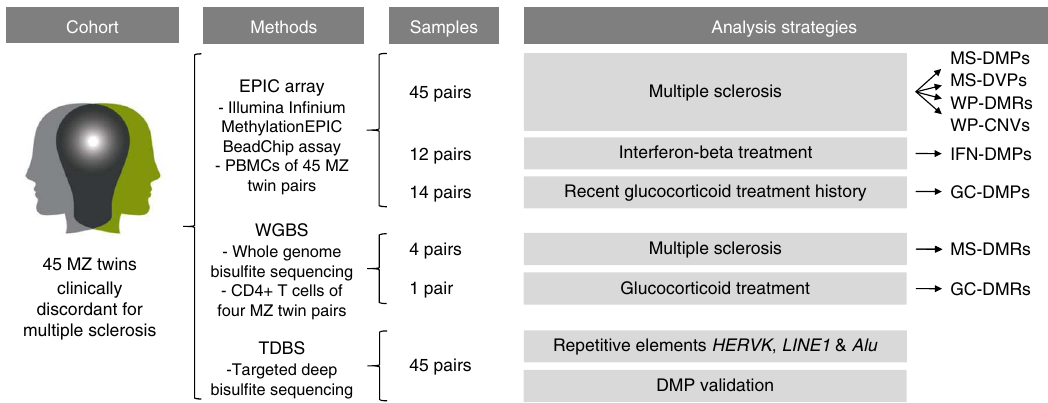
Fig. 1 Schematic overview of the study design and analysis strategies. DMPs, differentially methylated CpG positions; DMRs, differentially methylated regions; DVP, differentially variable CpG positions; GC-DMPs, glucocorticoid treatment-associated DMPs; HERVK, human endogenous retrovirus type K; IFN-DMPs, interferon-beta treatment-associated DMPs; LINE1, long interspersed nuclear element-1; MS-DMPs, multiple sclerosis-associated DMPs; MS- DVPs, multiple sclerosis-associated DVPs; MZ, monozygotic; PBMCs, peripheral blood mononuclear cells; WP - CNVs, within-pair copy-number variations; WP-DMRs, within-pair differentially methylated regions. The logo of the MS/TWIN/STUDY is not covered by the article CC BY license. Image credit goes to Lisa Ann Gerdes. All rights reserved, used with